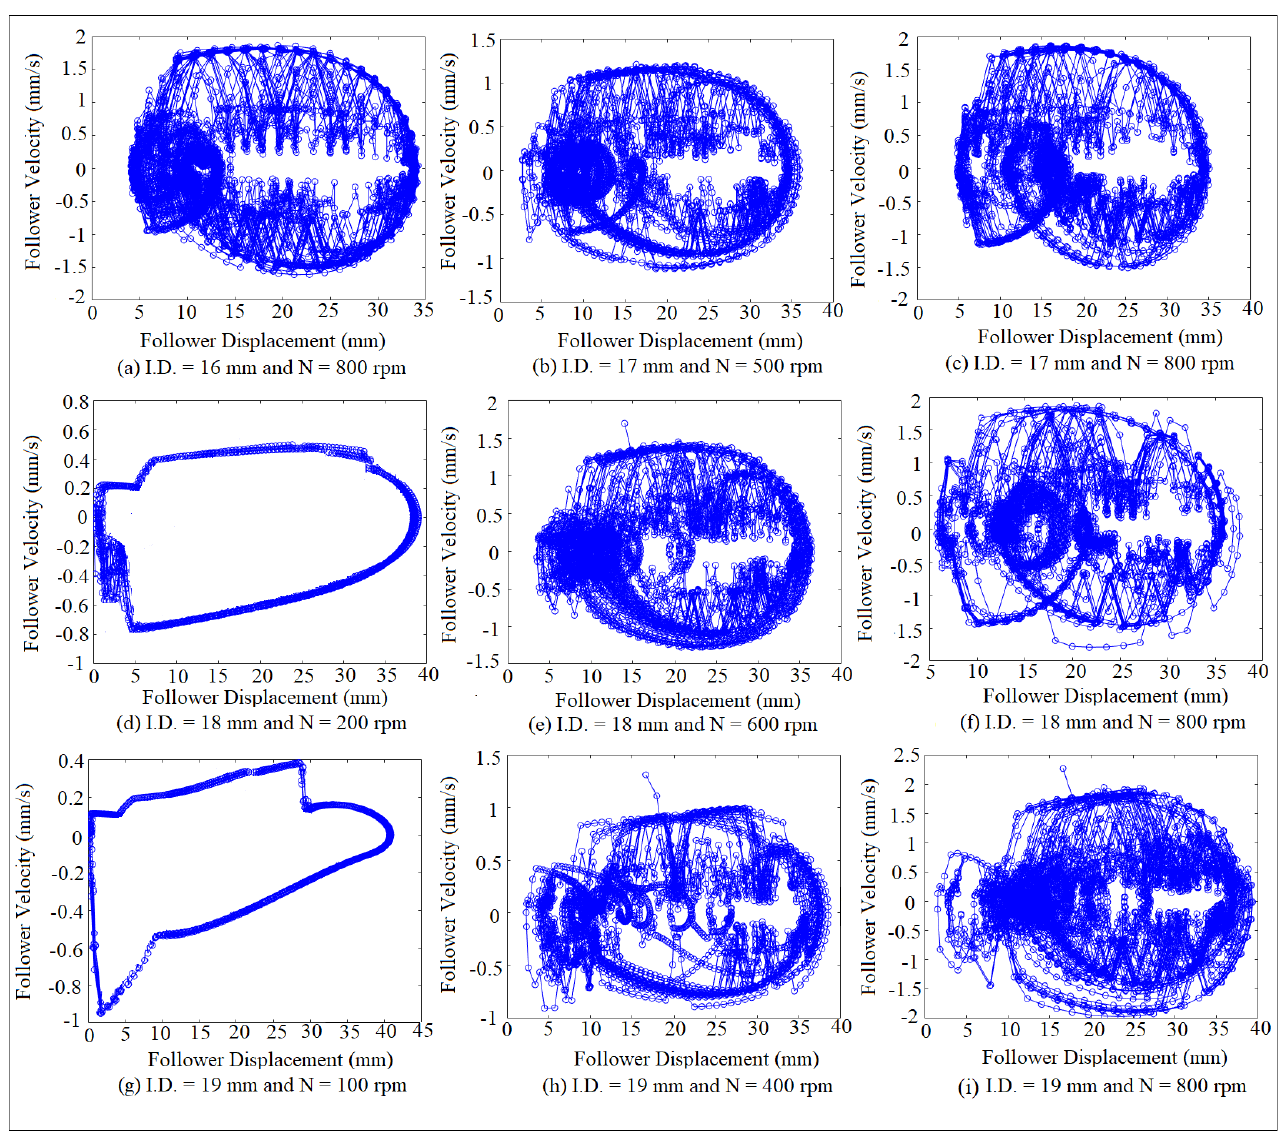
Figure 18. Phase-plane mapping for cam profile no.(1) at different (I.D.) and different (N).